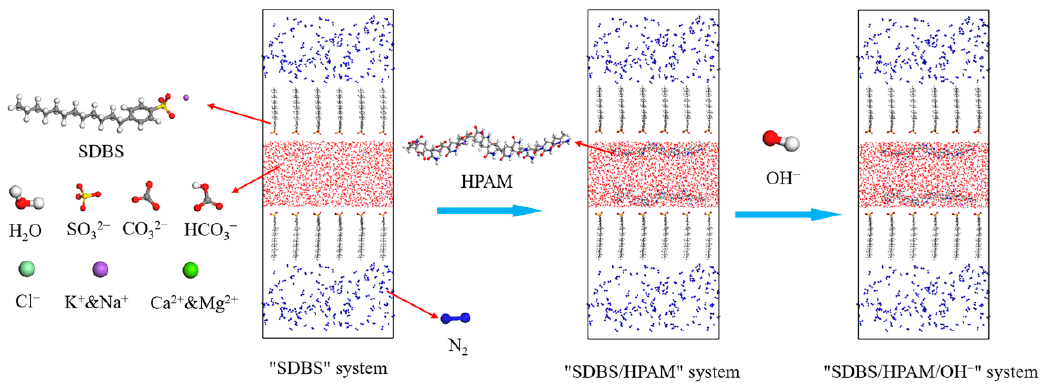
Figure 1. Illustration of simulation system construction. Table 1. Simulation scheme and molecular quantities in different foam